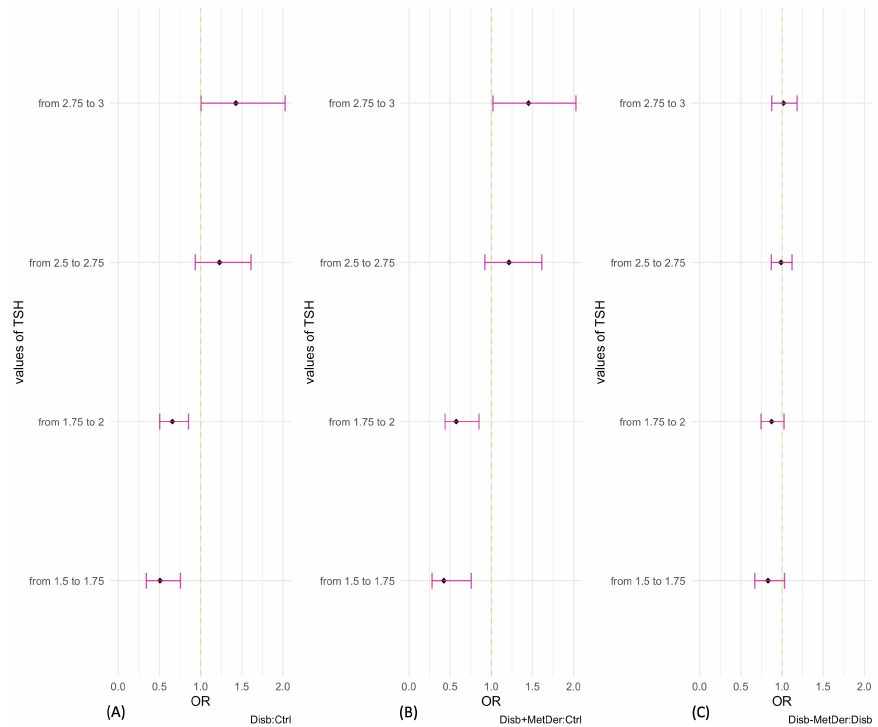
Figure 4. To facilitate the quantitative interpretation of the associations, odds ratios calculated for a fixed increase of 0.25 mLU/L from TSH values of 1.5 mLU/L up to 3 mLU/L are represented in this panel. Considering the association between being a child with neuromotor impairment and a control child and TSH ( A ), the odds ratios ranged from 0.51 to 1.43. Only the increases from 1.5 mLU/L to 1.75 mLU/L and from 1.75 mLU/L to 2 mLU/L are statistically significant. Considering the association between being a disabled child with MS and a control child. ( B ), the odds ratios ranged from 0.42 to 1.45. Only the increases from 1.5 mLU/L to 1.75 mLU/L and from 1.75 mlUL to 2 mLU/L are statistically significant. Considering the association between being a child with a disability and MS and a child with a disability ( C ), the odds ratios range from 0.8 to 1.01.